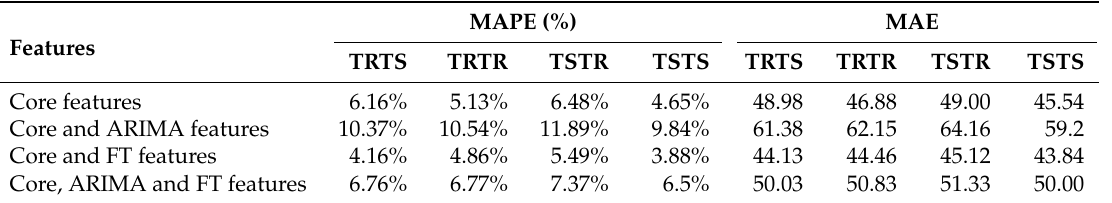
Table 3. TRTS, TRTR, TSTR, and TSTS accuracy for R-GAN (Building Genome data set). MAPE (%)